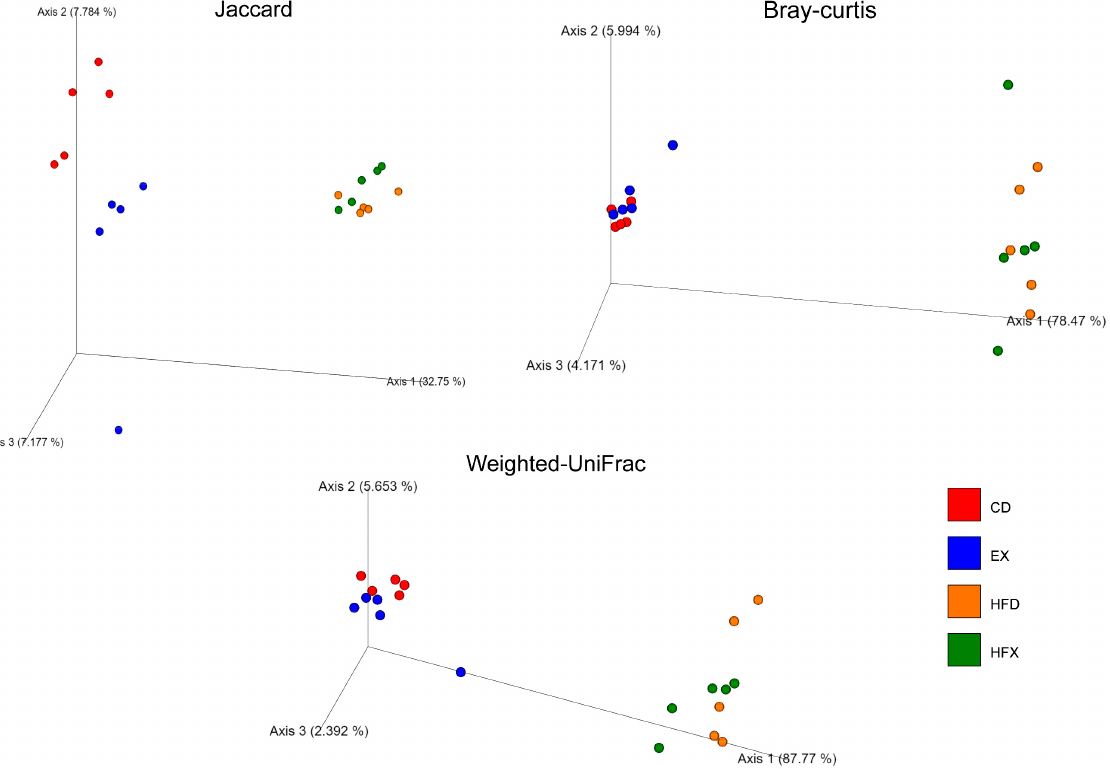
Figure 3. Principal co-ordinate analysis (PCoA) based on Jaccard, Bray–Curtis, and weighted UniFrac metrics for microbial community comparison, at the OTU level. The data points represent individual samples. Statistical significance was determined using PERMANOVA by comparing the true F statistics to the randomly permuted F statistics defaulted to 999 permutations. PERMDISP was used to confirm the significance analysis; Jaccard ( p = 0.03), Bray–Curtis ( p = 0.001), and weighted UniFrac ( p = 0.007).